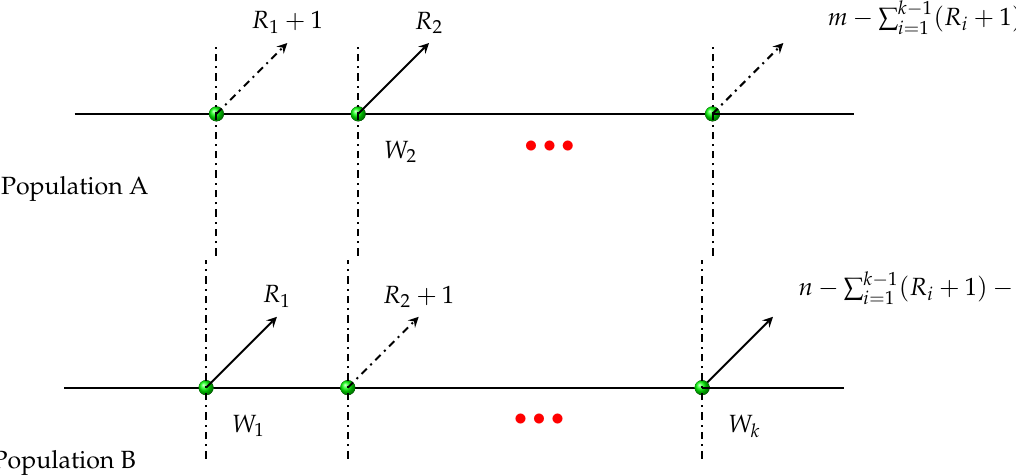
Figure 2. Schematic representation of the k -th failure occurring in population